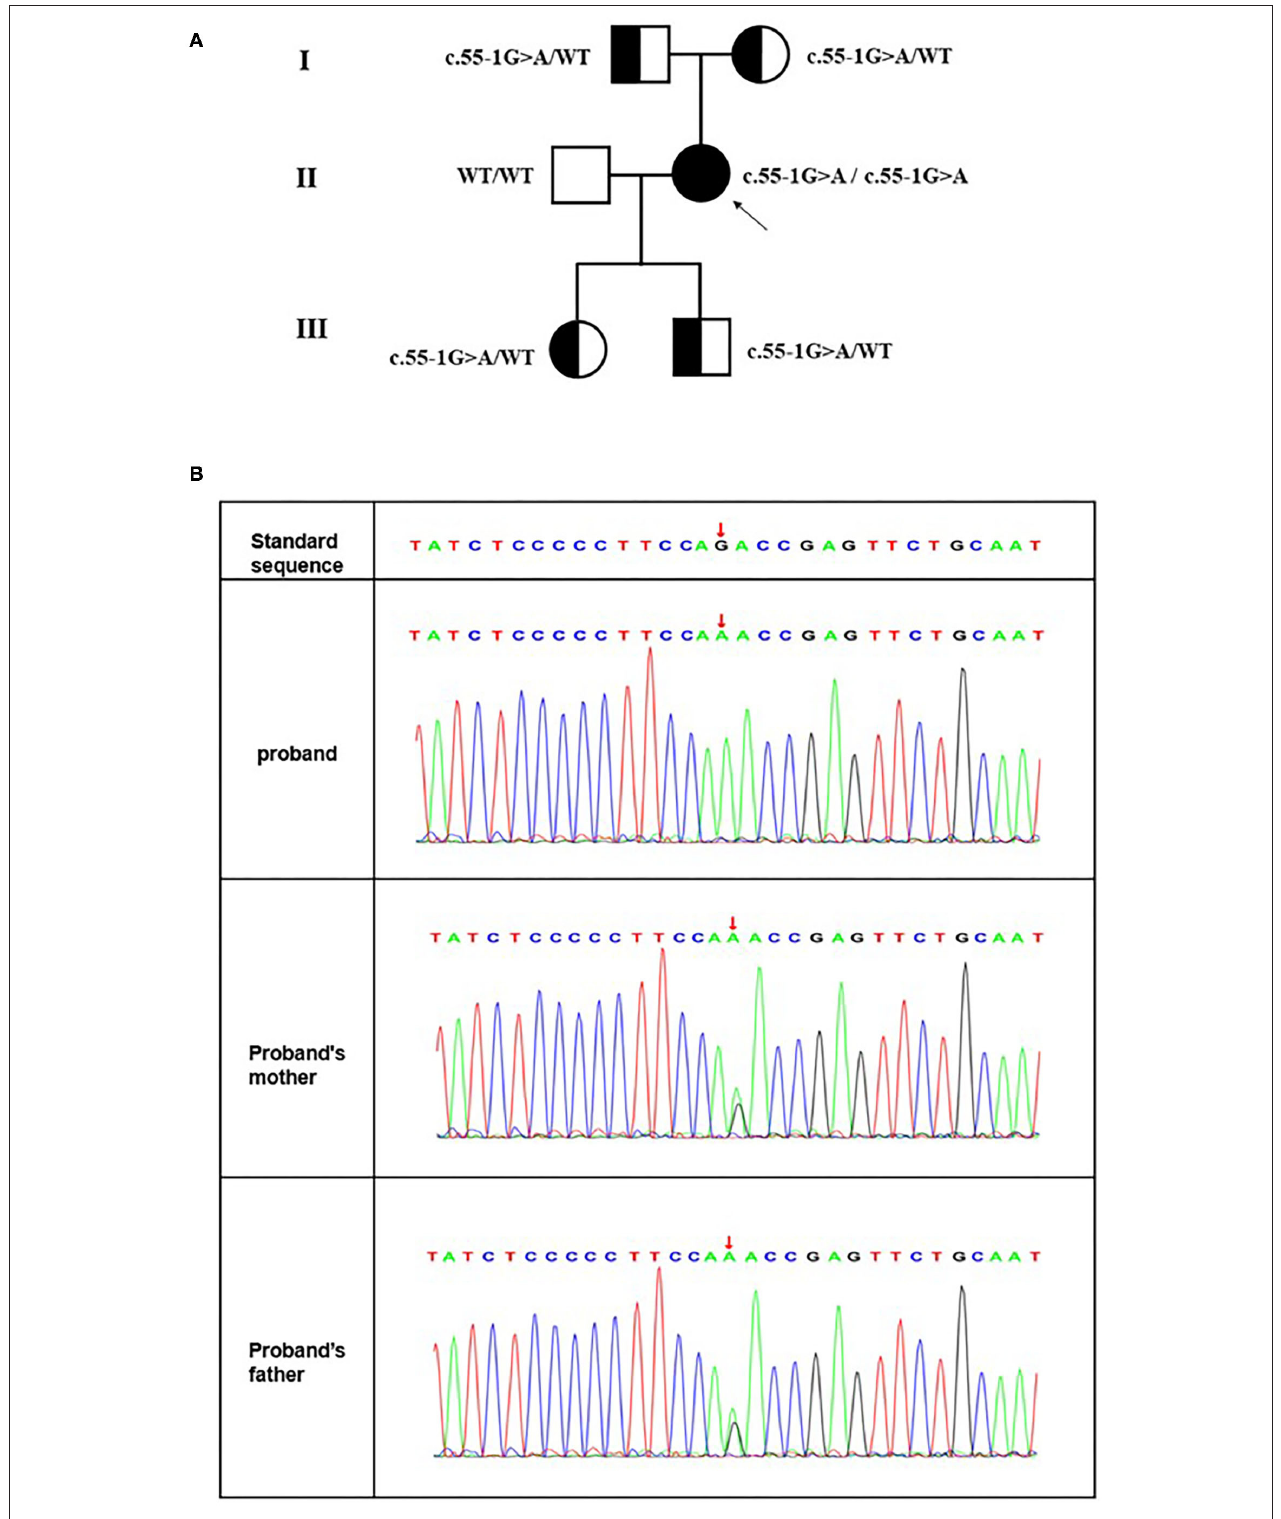
FIGURE 4 | (A) Pedigree of the consanguineous marriage family with an autosomal recession in microphthalmos. Squares and circles represent males and females, respectively. All filled symbols and arrows indicate the proband, and half-filled symbols indicate heterozygous genotype carriers. (B) A novel splice site